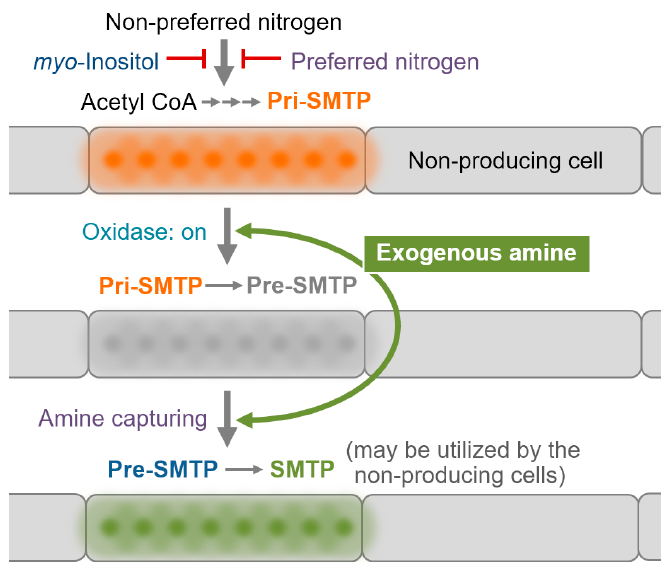
Figure 8. Possible mechanism fo the regulation of SMTP biosynthesis and its nutritional role. See text for details of the explanation of the scheme. Please note that the exogenous amine fed to the culture did not induce pri-SMTP oxidase (Figure 4C), and the amine added to the cell-free enzyme assay did not activate the oxidase activity (Figure 4E,F). However, pri-SMTP was consumed when the exogenous amine was added to the culture, but not when no amine was added (Figure 2E,F). Therefore, we assume that exogenous amines can trigger the oxidase reaction via a mechanism other than induction or direct activation, whereas the mechanism that triggers oxidase reaction is still